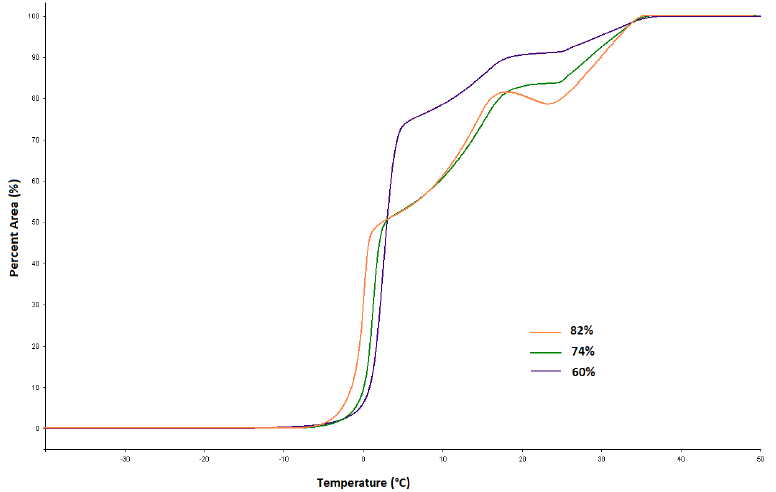
Figure 2. Curves of the percentage area calculated from DSC melting curves of the milk fat products with fat contents of 60%, 74% and 82%.